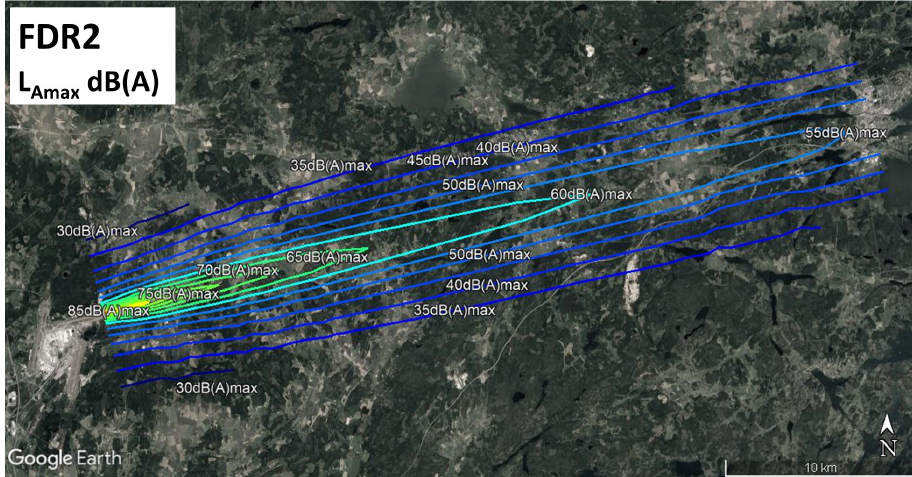
Figure 10. Noise prediction for FDR2 computed with SAFT ECAC Doc 29 implementation.